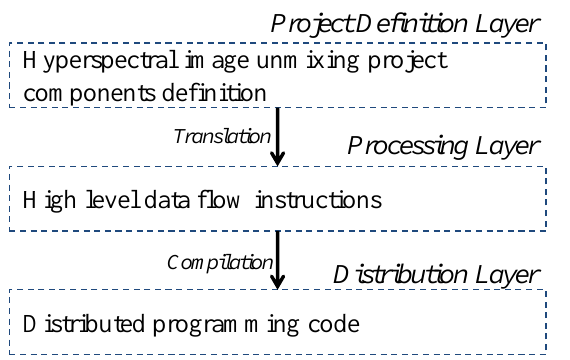
Figure 1. HyperCloud-RS